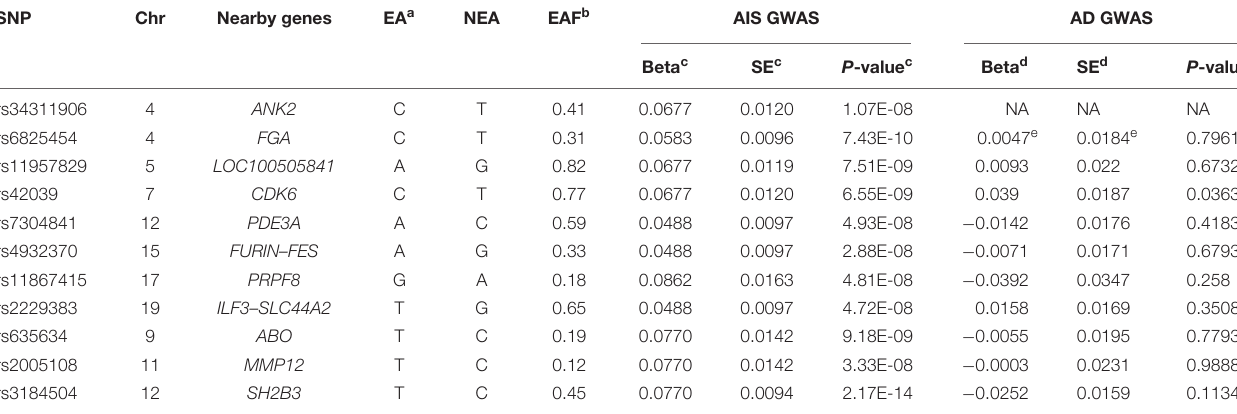
TABLE 2 | Characteristics of 11 genetic variants in AIS and AD GWAS